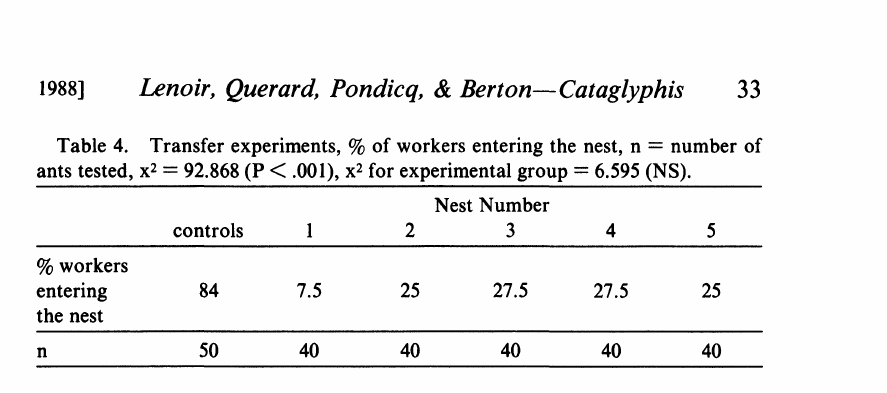
% workers entering the